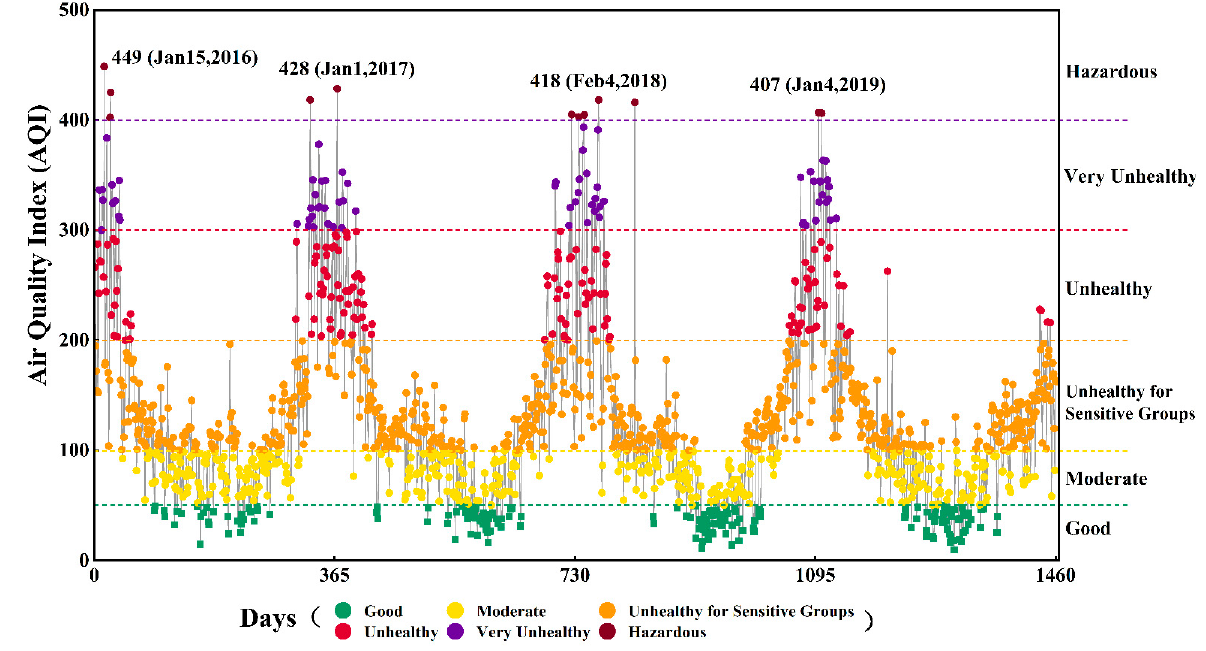
Figure 1. Air quality index in UB from 2016 to 2019. Table 2. Monthly statistics and proportions of major pollutants during each season from 2016 to 2019.